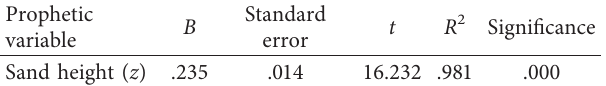
Table 5: Simple regression report.